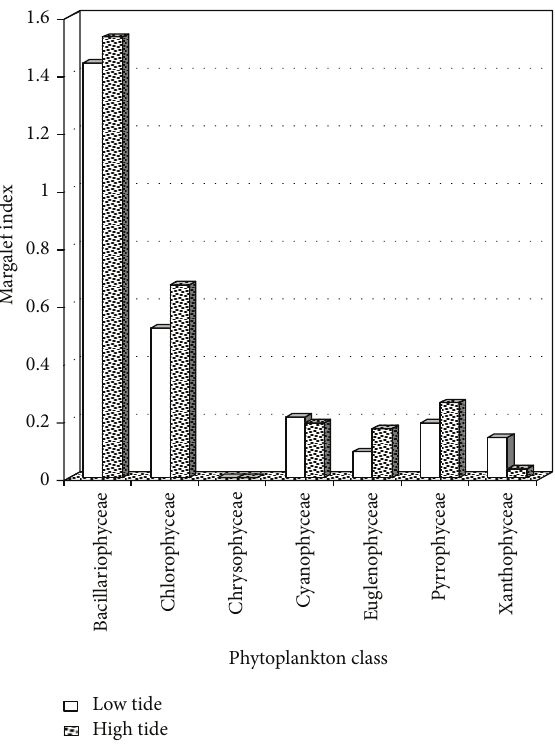
Figure 4: Variation of phytoplankton Margalef index. Variations of phytoplankton parameters in relation to tide in Okpoka